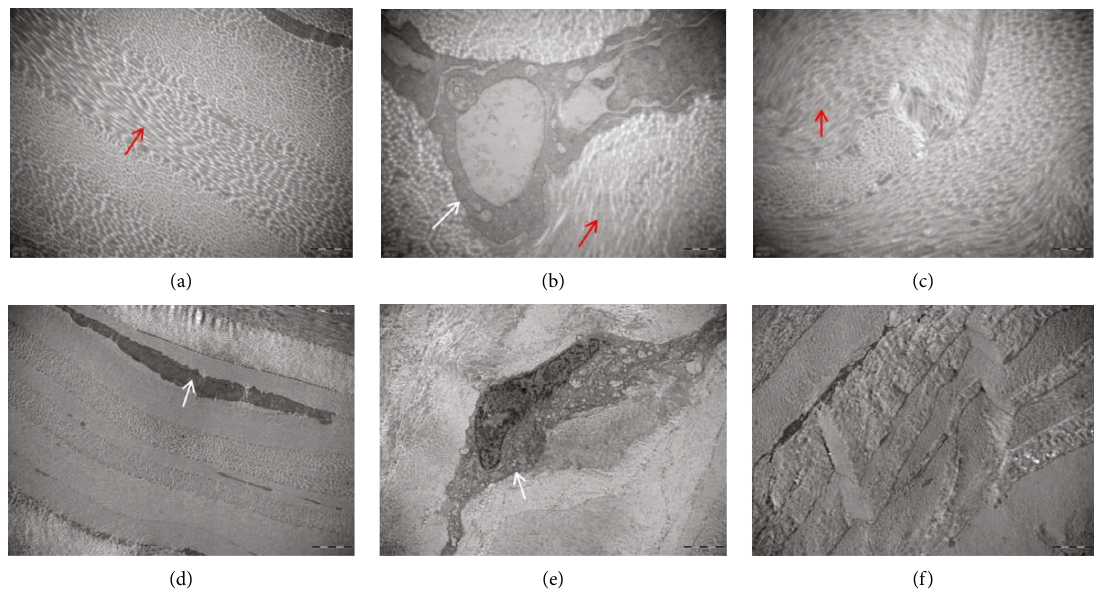
Figure 6: The postoperative TEM results of each group. (a, d) The lamellar structure of the cornea in group A was clearly visible (red arrow), and there were obviously flat and slender fibroblasts (white arrow) between the lamellar structures. (b, c) The fiberboard layers of group B (b) and C (c) were disordered (red arrow), and there were a few autophagosomes in the fibroblasts of group B. (c, f) The lamellar structure of group C was clear and more closely arranged (c, f). (a–c):10 K × 40, ruler: 500nm, (d–f)10K × 10 ruler: